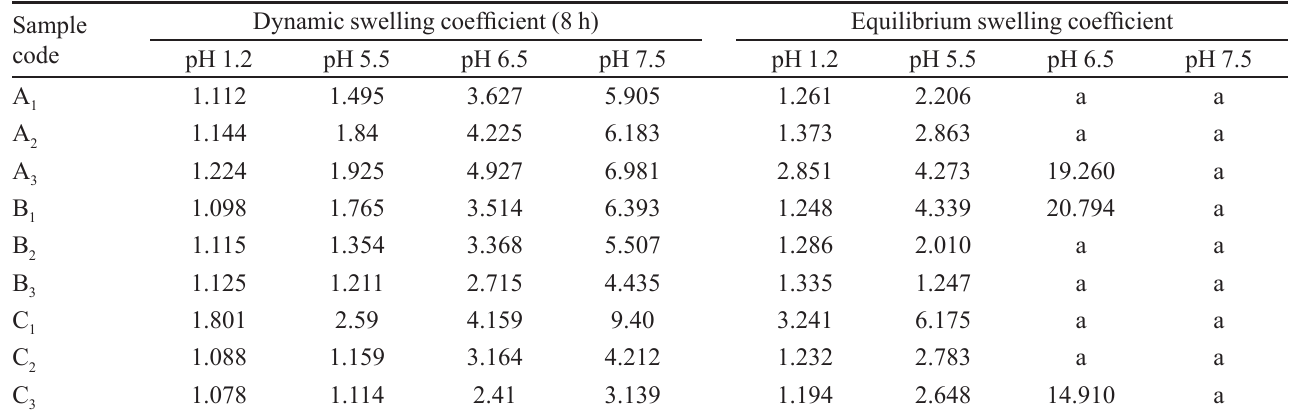
TABLE II - Dynamic and equilibrium swelling coefficients of PVP/AA hydrogels using MBA as cross-linking agent Sample